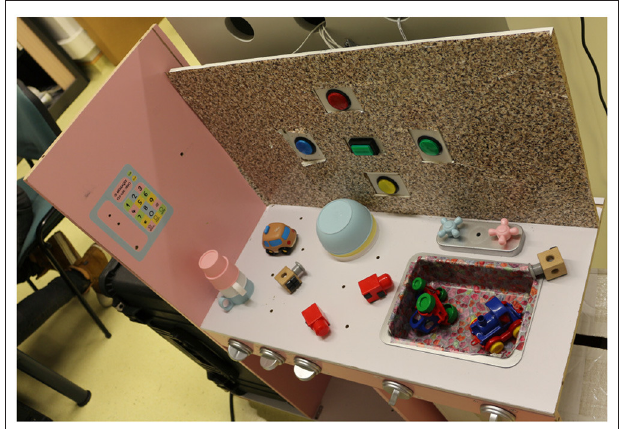
FIGURE 7 | The setup used for all the experiments. The setup is a toy kitchen with 5 interactive push buttons integrated into a vertical plane.